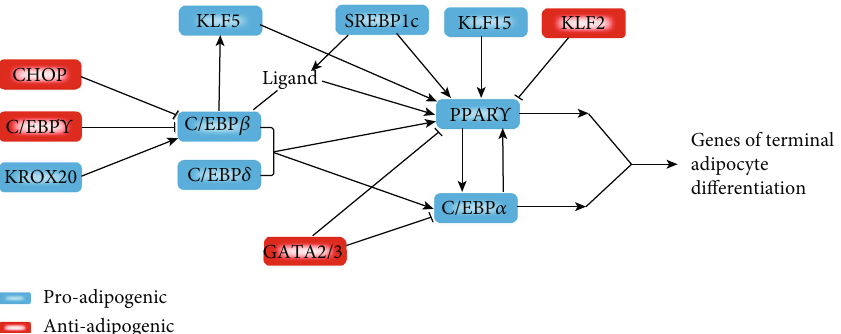
Figure 2: A cascade of transcription factors that regulate adipogenesis. PPAR γ is one of the key transcription factors in adipogenesis and the core of the transcriptional cascade that regulates adipogenesis. PPAR γ expression is regulated by several proadipogenic (blue) and antiadipogenic (red) factors. C/EBP α is regulated through a series of inhibitory protein – protein interactions. Some transcription factor families include several members that participate in adipogenesis, such as the KLFs. Black lines indicate e ff ects on gene expression; violet lines represent e ff ects on protein